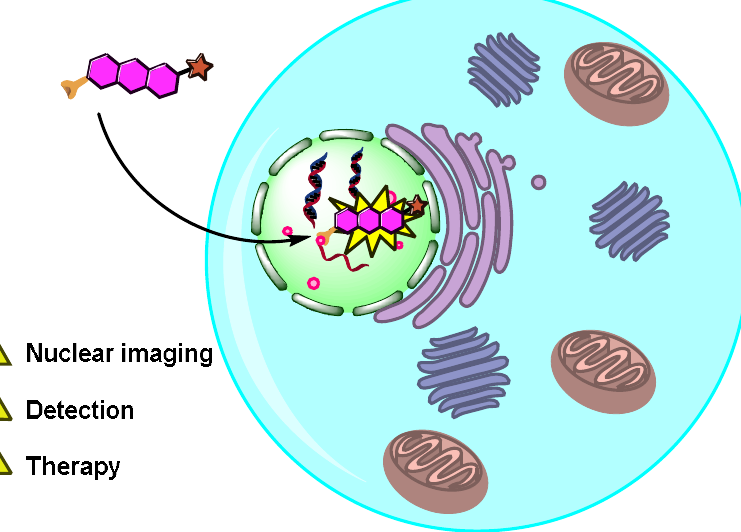
Figure 1. Schematic representation of the chemical molecular labelling method.